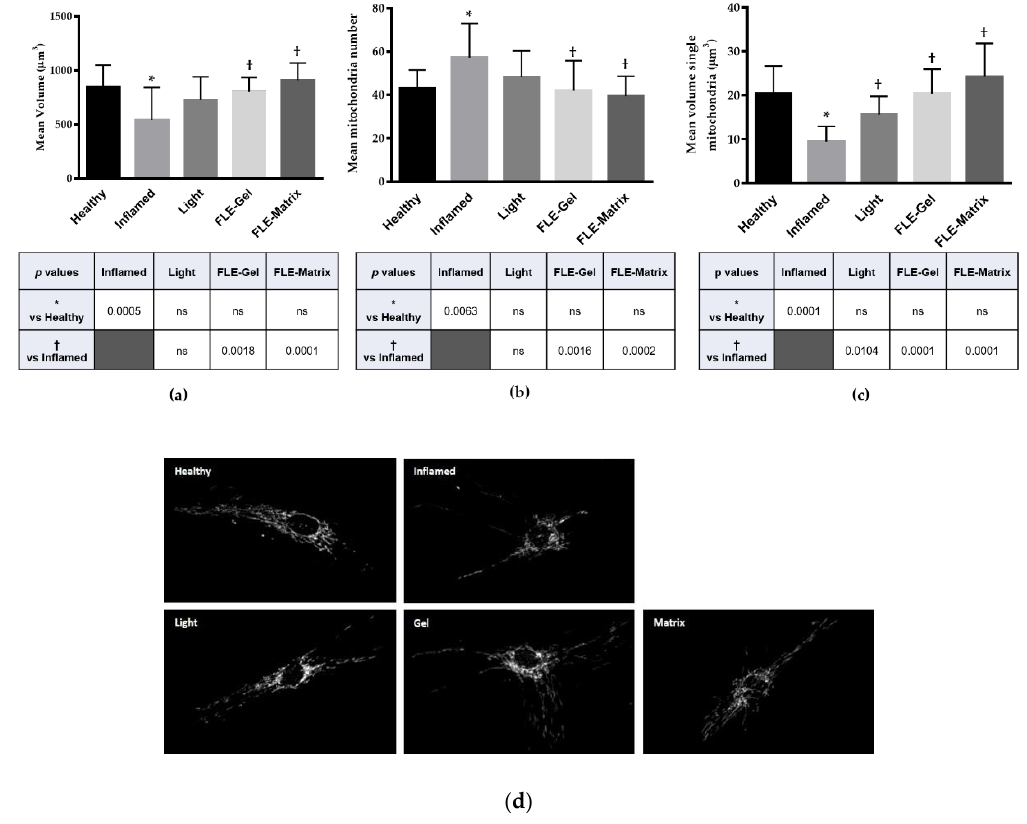
Figure 2. Quantification of mitochondrial network 24-h post-treatment. After deconvolution, images were 3D reconstructed and the mitochondrial network was evaluated by automated estimation of ( a ) volume of the entire mitochondrial network per single cell, ( b ) number of mitochondria per single cell, and ( c ) volume of single mitochondrion. Data are expressed as mean ± SD. Multi comparison statistical analysis were performed by using one - way analysis of variance (ANOVA). T test was to perform all pairwise comparisons between group means. * p < 0.05 from Healthy human dermal fibroblasts (HDFs), † < 0.05 from Inflamed human dermal fibroblasts (HDFs), ns = not significant. ( d ) Representative images. FLE: fluorescent light energy.